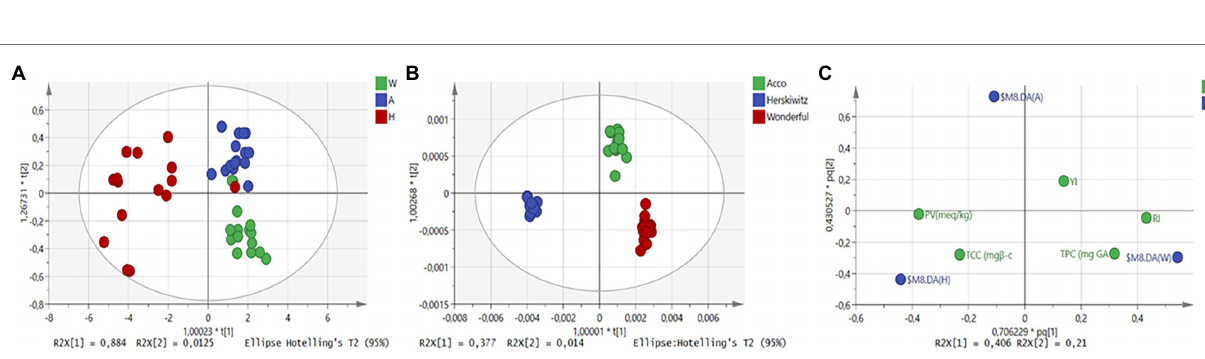
FIGURE 2 | PCA score plots for NIR spectral data (A) and MIR spectral data (B) . The colour represents different cultivars of extracted pomegranate oil, green (Acco), blue (Herskawitz), and red (Wonderful) (sample number =